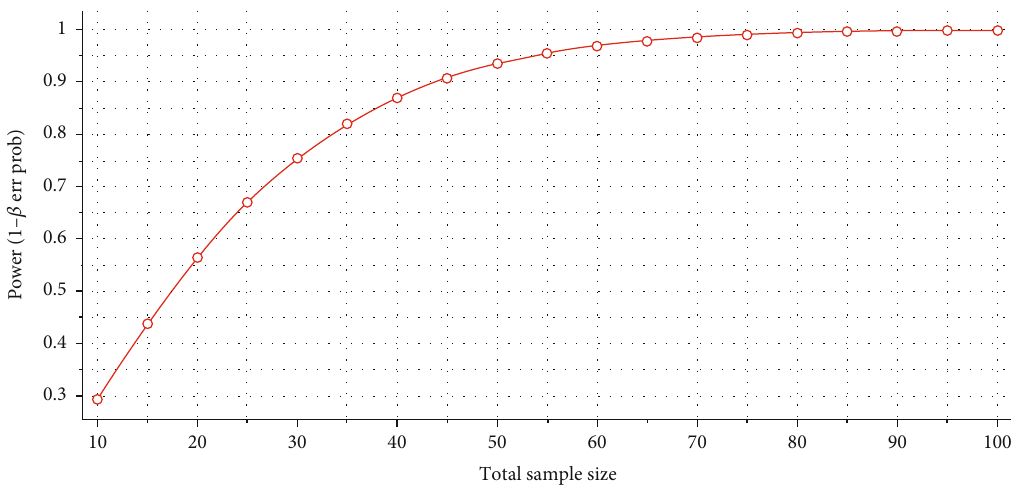
Figure 5: The plot of the sample size and statistical power. Table 1: Information of the eligible